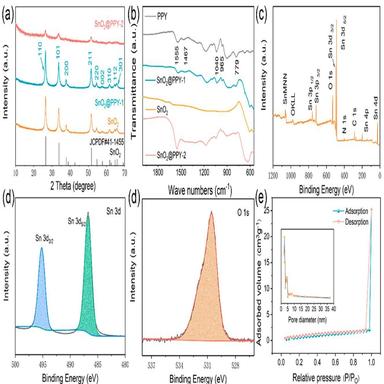
XRD patterns (a) and FT-IR spectra (b) of all samples; XPS profiles (c), Sn 3d (d) and O 1 s (e) spectrum of the SnO2 @PPy-2 composites; The nitrogen (N2) adsorption/ desorption isotherms and pore size distributions (f) of SnO2 @PPy-2;.